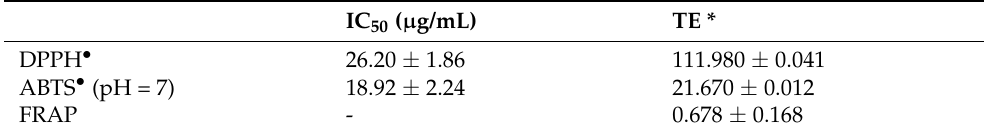
Table 4. Antioxidant activity of ethanolic extract (Cv 70% EtOH) from Crepis vesicaria L. subsp. taraxacifolia